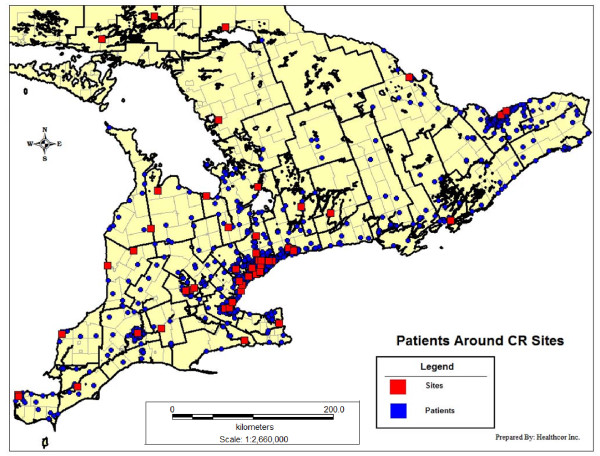
Spatial distribution of participants and CR sites in the Southern corridor of Ontario.